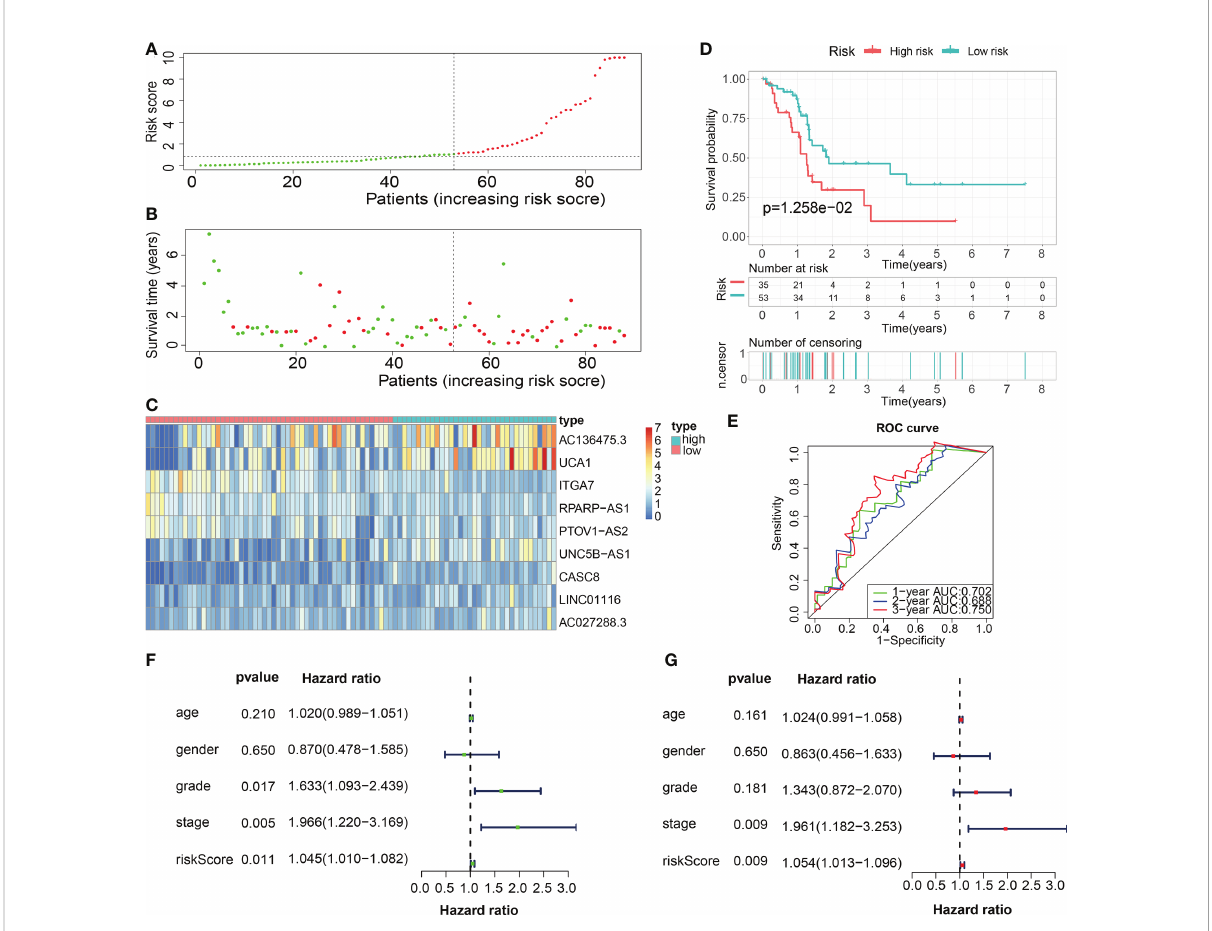
FIGURE 9 Internal validation of the robust ECM-APP in the test1 cohort. (A) Sectionalization premised on the median risk score. (B) Survival status and risk score distributions (C) Heatmap depicted the expression pro fi les of 9 genes integrated into the prognostic signature. (D) Survival curve of OS time in low-risk and high-risk subgroups. (E) ROC curve of 1-, 2-, and 3-years of test1 cohort, area under the curve (AUC) of the curve are 0.702, 0.688, and 0.750, correspondingly. (F) Univariate cox regression analysis illustrated the independence of risk score, stage, grade, gender, and age. (G) Multivariate cox regression analysis showed the independence of risk score, stage, grade, gender, and